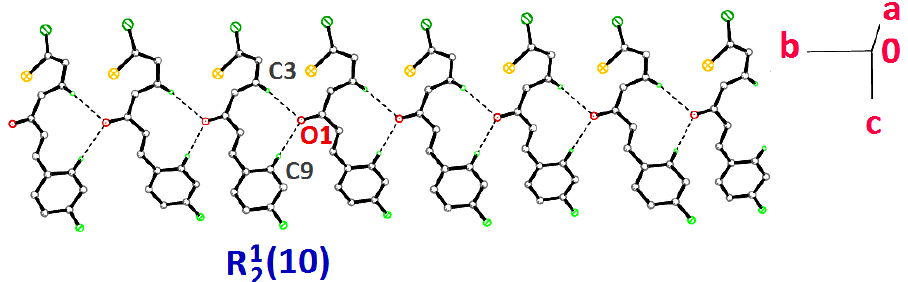
Figure 5. Crystal structure of 3c forming chains along the b -axis. Dashed lines indicate the intermolecular hydrogen